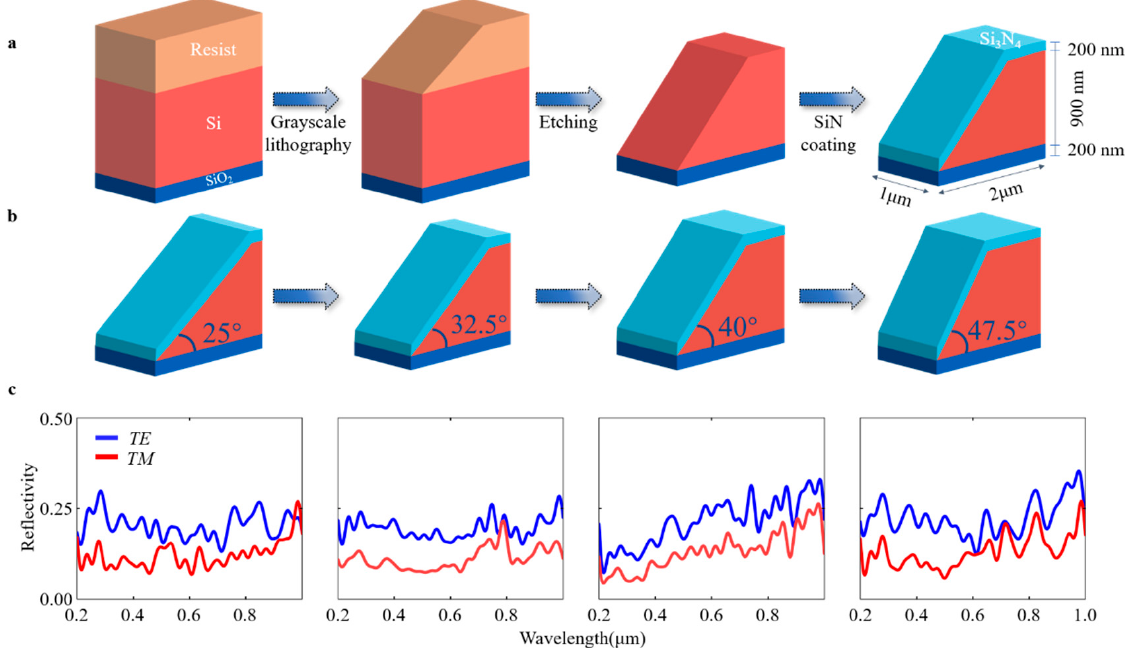
Figure 1. The flow chart of the manufacturing process and encoding strategy. ( a ) The nanostructure manufacturing process, ( b ) Variation in structure according to slope angle, and ( c ) Wavelength-based reflectivity spectra of different slope angles.